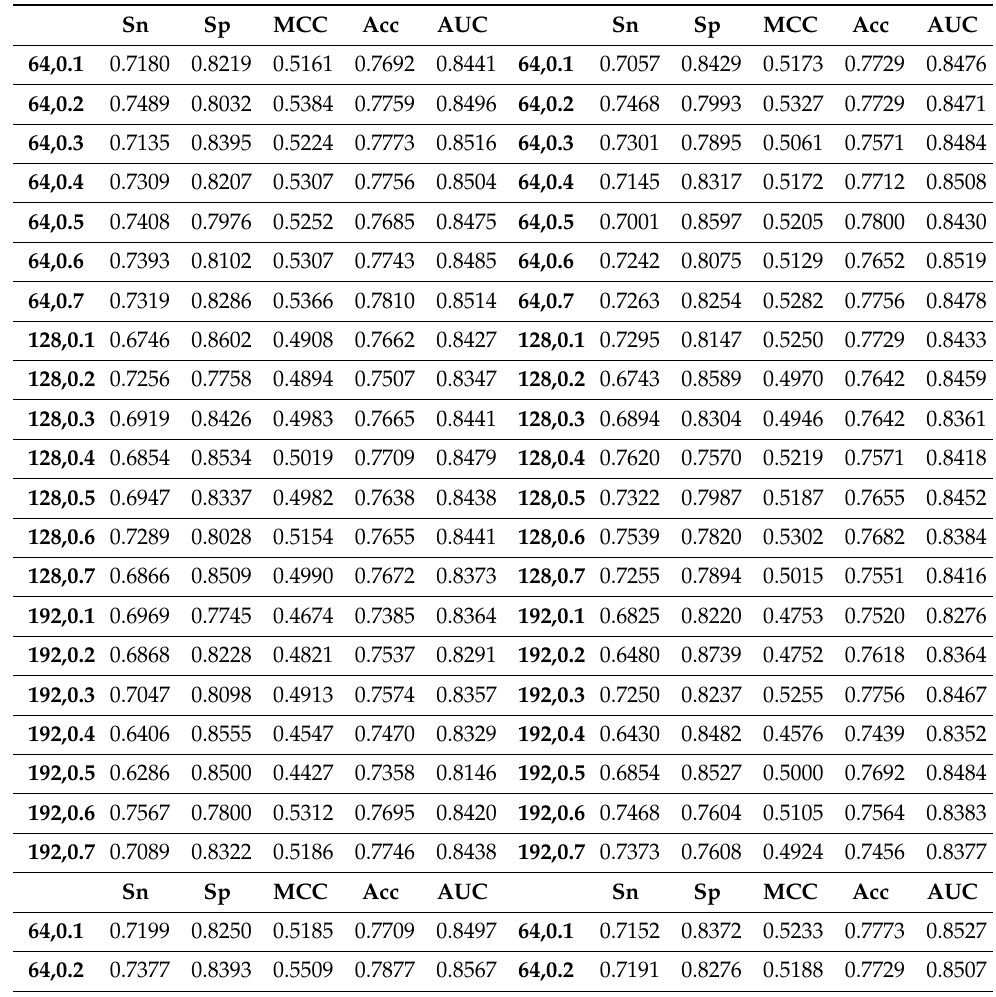
Table 3. Performance of different hyperparameters on the test dataset. ‘Upper left corner’: When pBatchSize = 16, traverse the collection of pDropoutRatio and pLSTMSize. ‘Upper right corner’: When pBatchSize = 32, traverse the collection of pDropoutRatio and pLSTMSize. ‘Middle left’: When pBatchSize = 64, traverse the collection of pDropoutRatio and pLSTMSize Collection. ‘Middle right’: When pBatchSize = 128, traverse the collections of pDropoutRatio and pLSTMSize. ‘Lower left corner’: When pBatchSize = 256, traverse the collections of pDropoutRatio and pLSTMSize. ‘Bottom right corner’: When pBatchSize = 512, traverse the collections of pDropoutRatio and pLSTMSize. In each subgraph, the first row gives the values of the five prediction performance metrics—i.e., Sn,